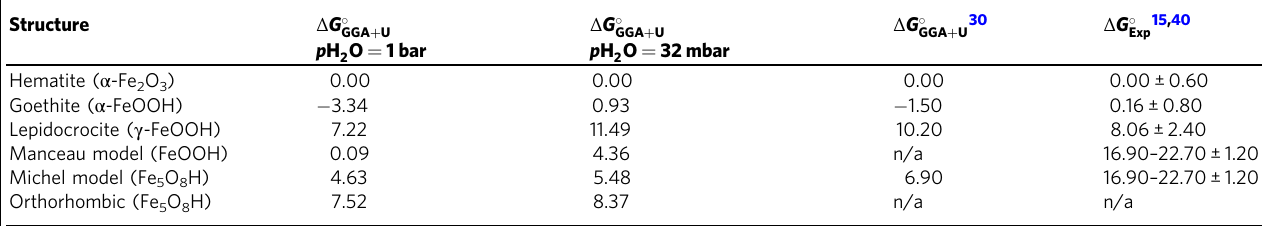
Table 1 Gibbs free energies of bulk mineral phases. Structure